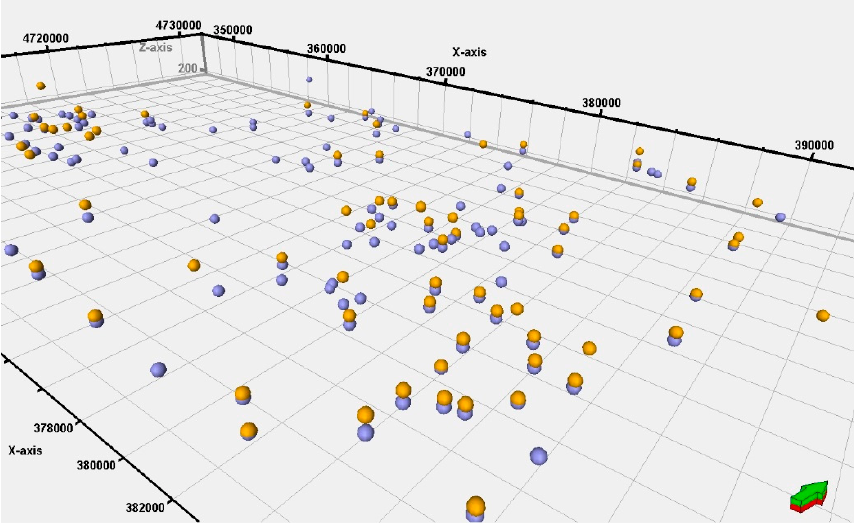
Figure 5. Screenshot of perspective view of point data used to build the top of the Sub-Tiskilwa Sand/Gravel (orange dots) and the top of the Winnebago Fm. surface (purple dots). Green arrow points north.